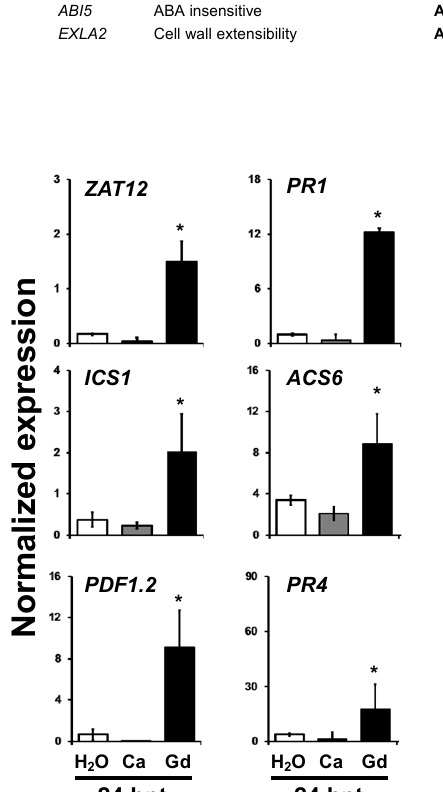
Figure 7. Gd transcriptionally activate the plant defense response genes. ( A ) Heatmaps of the expression log2-fold changes of genes previously described to be involved in the resistance against B. cinerea [10], compared to the corresponding controls, from RNAseq data at 24 hpt and hpi. ( B ) Four-week-old A. thaliana plants pretreated with H 2 O (mock), 0.2 g/L Ca, or Gd (24 hpt). Quantitative real-time PCR (qRT-PCR) expression analysis of ZAT12 , ICS 1, PR1 , ACS6 , PDF1.2, and PR4 was determined and normalized with respect to the mean of two reference genes AT4G26410 and AT1G72150 , as previously described [43,44]. A representative experiment with three technical replicates is shown ( ± SE). Three independent experiments were carried out with similar results. Asterisk above each bar represents statistically significant differences to the mock-treated samples according to the Student’s T -test ( p <